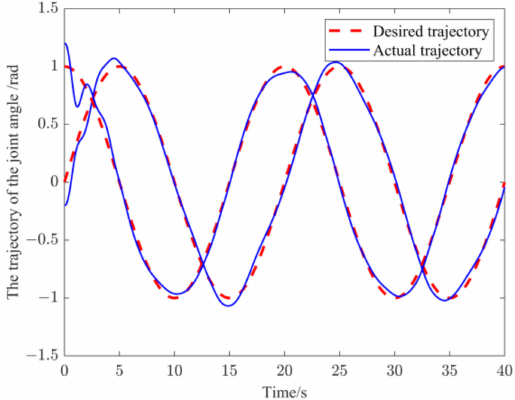
Figure 8. The trajectories of the joint angle q